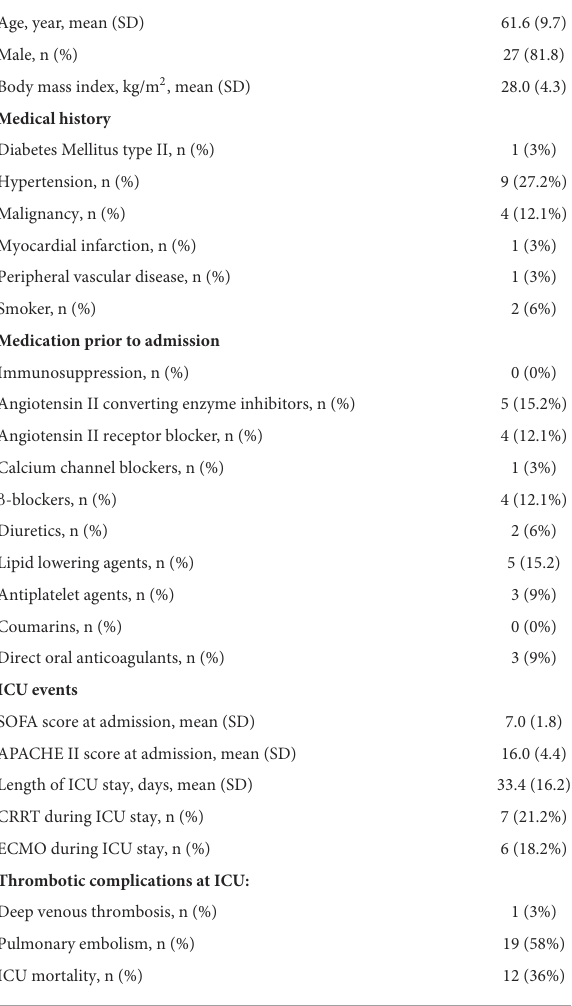
TABLE 1 Patient